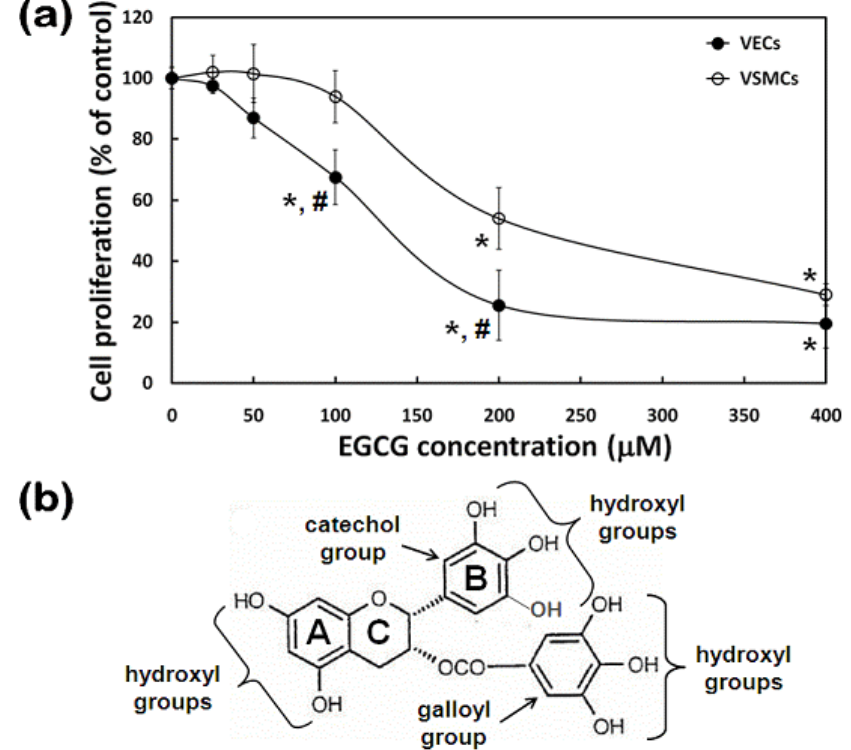
Figure 3. (a) Effects of EGCG on proliferation of VECs and VSMCs. (b) Chemical structures of EGCG, the main polyphenolic constituents of green